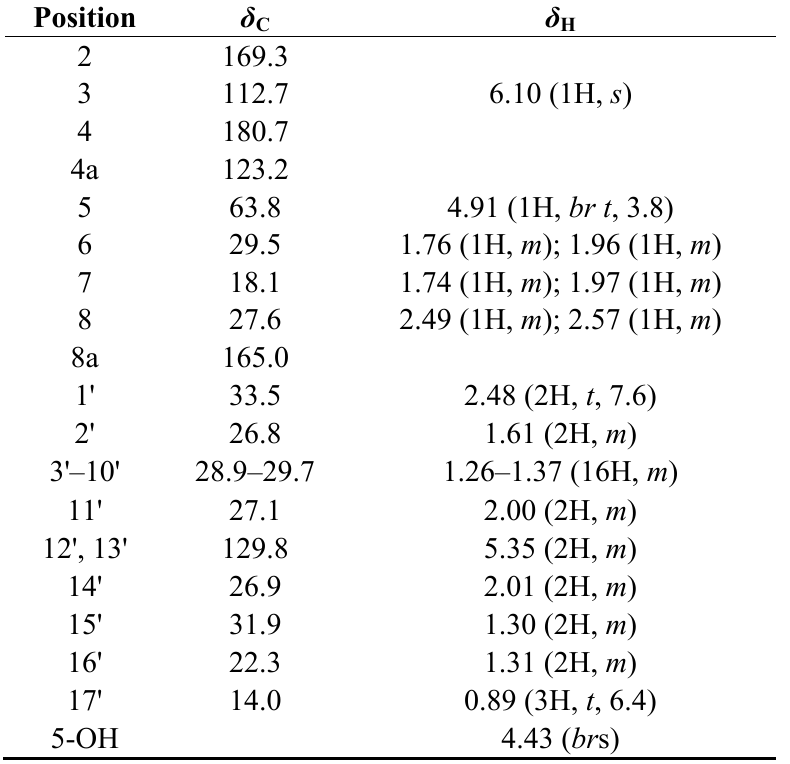
Table 2. 1 H- (400 MHz) and 13 C-NMR (100 MHz) data of compound 2 (in CDCl ppm, J in Hz).